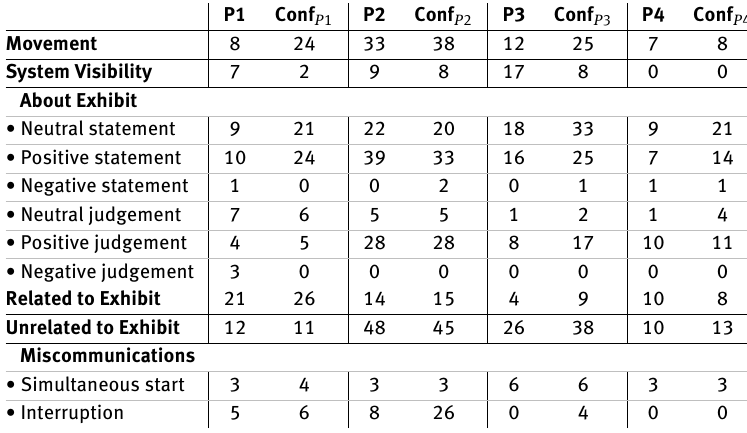
Table 7. Number of utterances volleyed between confederate (Conf) and participant during participant’s second gallery visit (S2)